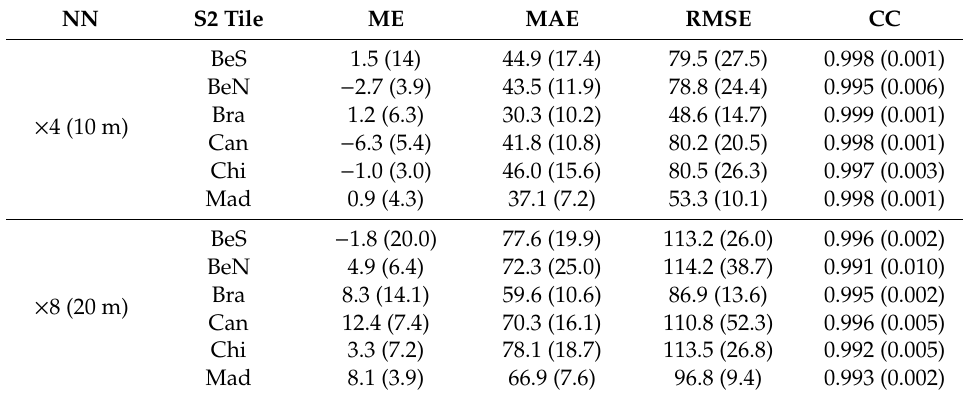
Table 4. Measured quality of the two super-resolution neural networks (NNs): from 10 to 2.5 m ( × 4) and from 20 to 2.5 m ( × 8). Focus on variations between PS strips for the six selected S2 tiles. ME, mean error; MAE, mean absolute error; RMSE, root mean square error; CC, cross correlation. The values correspond to mean (standard deviation) of the quality measures computed separately for each PS strip. See Table 1 for the number of strips by tile. NN S2 Tile